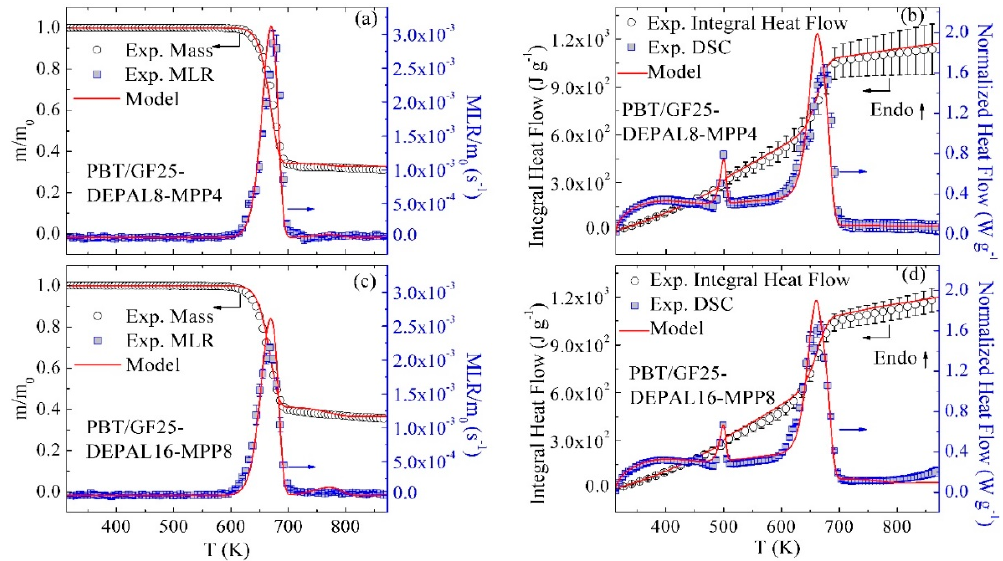
Figure 8. Experimental and simulated TGA and DSC data obtained for ( a , b ) PBT/GF25-DEPAL8-MPP4 and ( c , d ) PBT/GF25-DEPAL16-MPP8 at 10 K · min − 1 .